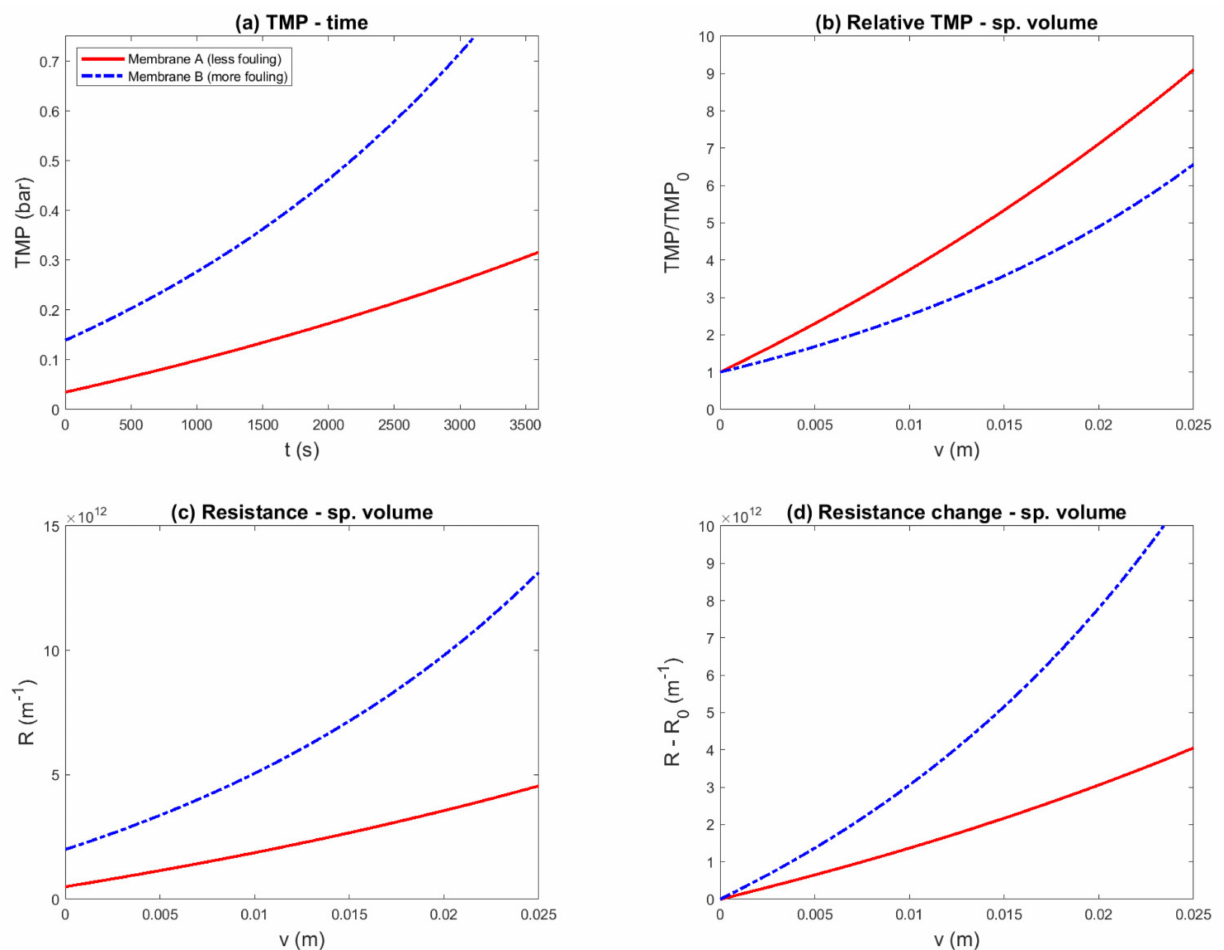
Figure 6. Simulated constant-flux experiment, aiming to compare two membranes. The example was constructed such that membrane A was superior to membrane B, due to a lower membrane resistance ( R MA = 0.5 × 10 12 m − 1 vs. R MB = 2.0 × 10 12 m − 1 ), a lower fouling rate ( α A = 3.0 × 10 13 m − 2 vs. α B = 6.0 × 10 13 m − 2 ), and a lower structural parameter ( s A = 3.75 × 10 − 4 vs. s B = 7.5 × 10 − 4 ( r = 10 nm ) and D = 1 × 10 − 10 m 2 /s, Π F = 0.25 bar ). Different representations ( a —TMP–Time; b —Relative TMP–Specific Volume; c —Resistance–Specific Volume; d —Resistance Change–Specific volume) were compared to evaluate if the known difference in fouling propensity was correctly reflected: Relative transmembrane pressure ( b ) suggests a conclusion that contradicts the underlying